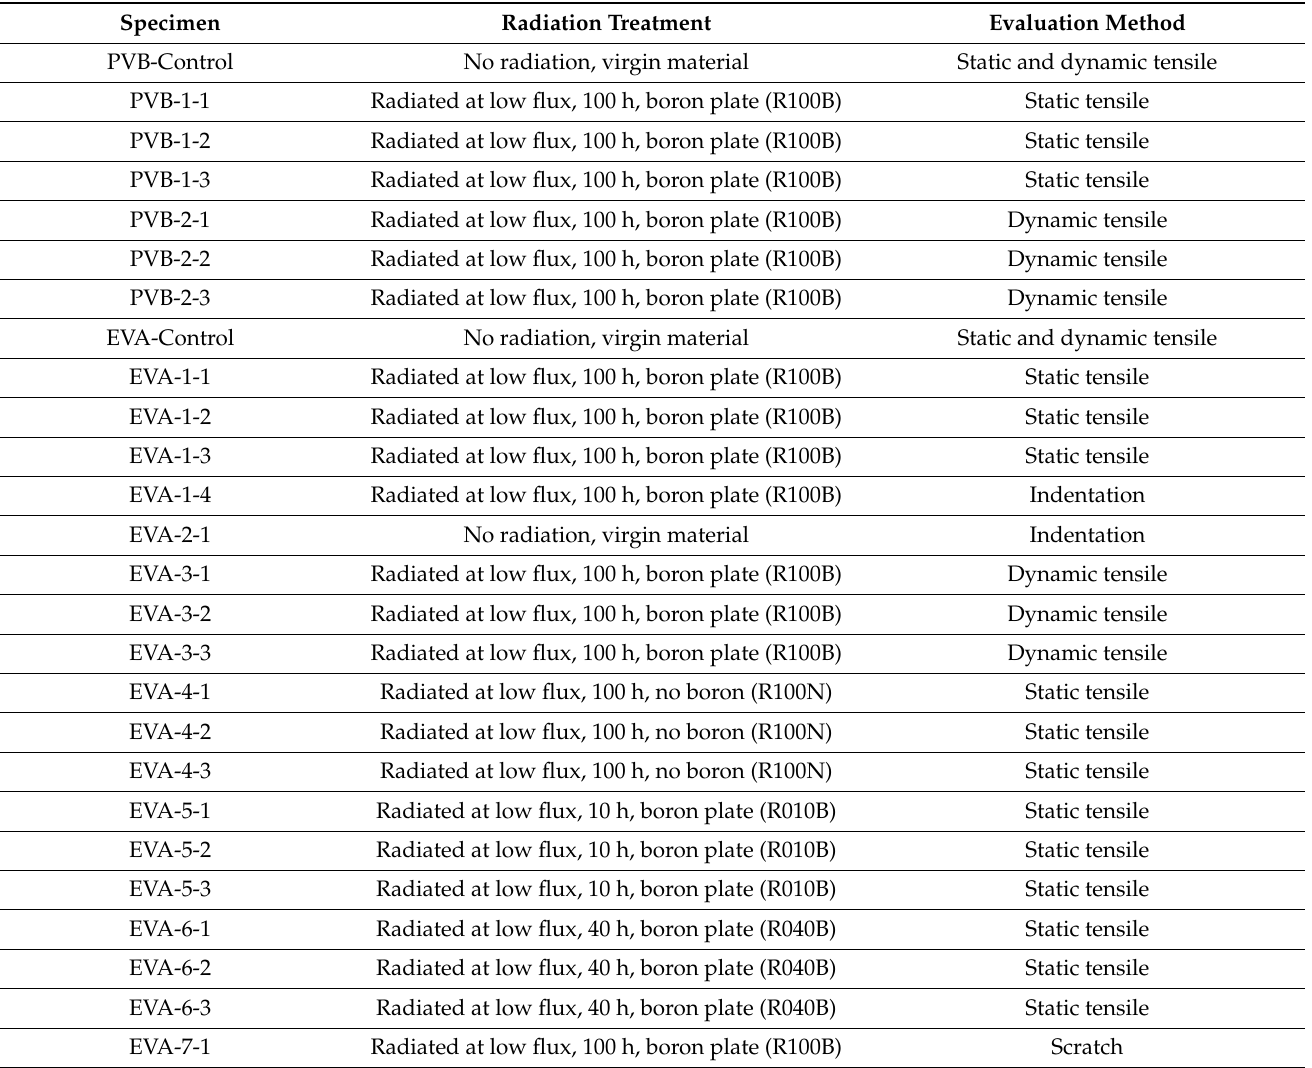
Table 1. Test matrix of